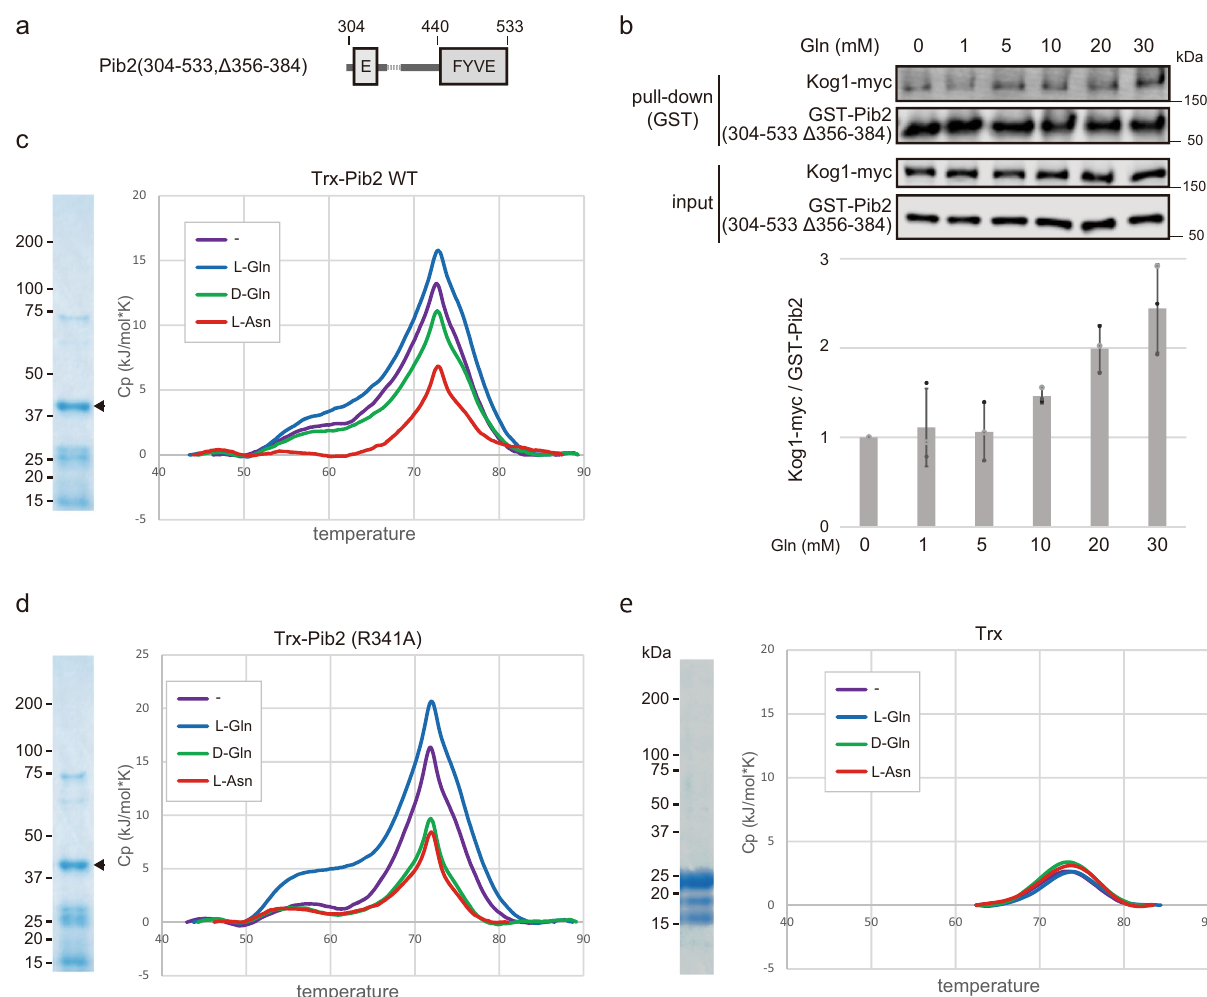
Fig. 5 L-glutamine speci fi cally changes Pib2 status. a Schematic diagram of Pib2(304-533, Δ 356-384) was used for DSC measurements. b Pib2(304- 533, Δ 356-384) interacts with TORC1 in response to glutamine. In vitro pull-down assays were performed (as in Fig. 1c) using GST-Pib2(304-533, Δ 356- 384) and yeast cell lysates prepared from Kog1-myc-expressing cells (TS270) with or without the indicated concentrations of L-glutamine. The line graph shows Kog1-myc bound to GST-Pib2(304-533, Δ 356-384) normalized to sample without glutamine. The bar graph shows GST-Pib2-bound FLAG-Tor1 normalized to the samples without glutamine. Error bars represent the standard deviation ( n = 3 independent experiments). c , d L-glutamine enhanced the Δ H of Pib2 heat-induced unfolding. c Thioredoxin (Trx)-tagged Pib2(304-533, Δ 356-384) was subjected to DSC measurements with or without the indicated amino acids (20 mM). Puri fi ed samples were analysed by SDS-PAGE followed by CBB staining. d Trx-tagged Pib2(304-533, R341A, Δ 356-384) was subjected to DSC measurements as in ( c ). e L-glutamine did not affect Trx, as determined by DSC measurements. Trx was subjected to DSC measurements as in ( c